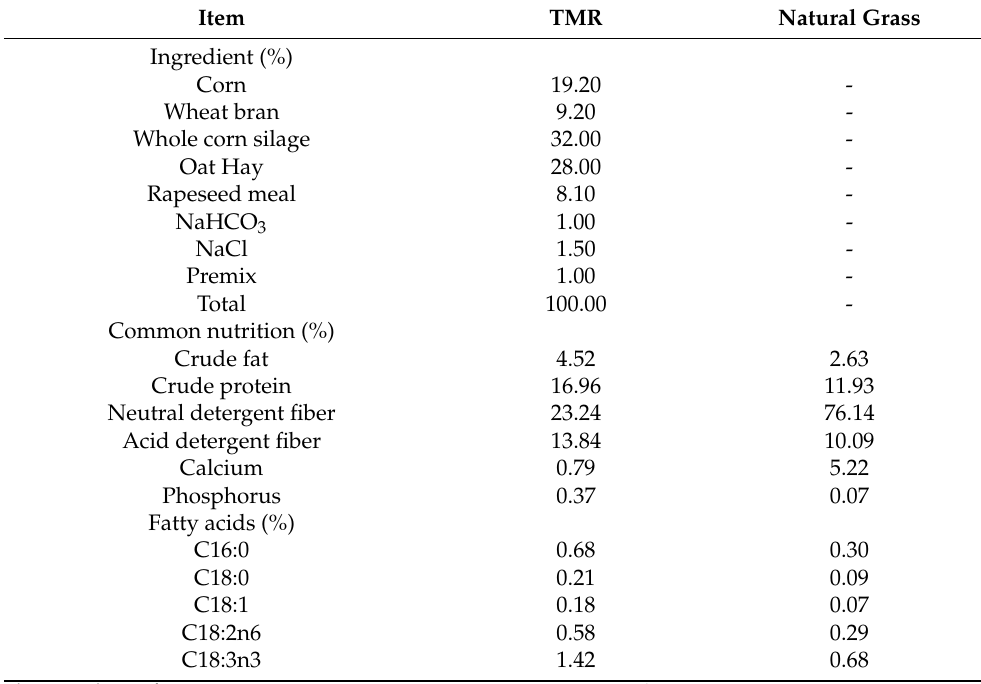
Table 1. The composition of the total mixed ration (TMR) and the content of common nutrition and major fatty acid in natural grass and TMR (air-dry